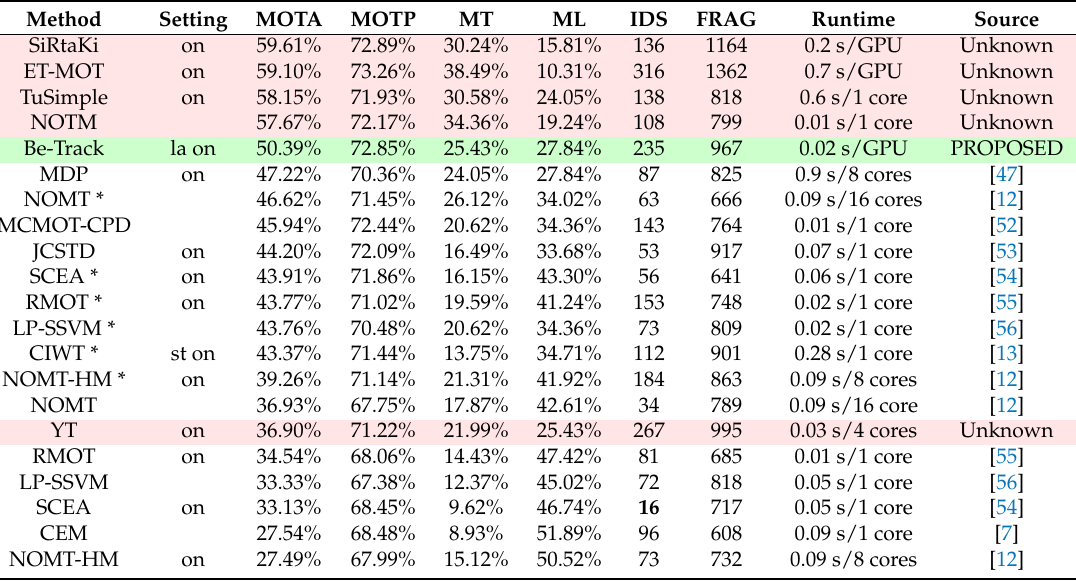
Table 1. Results on KITTI pedestrian tracking dataset sorted by MOTA score. Setting on = Online, la = Laser Data, st = Stereo Data. Red rows belong to submissions from unknown